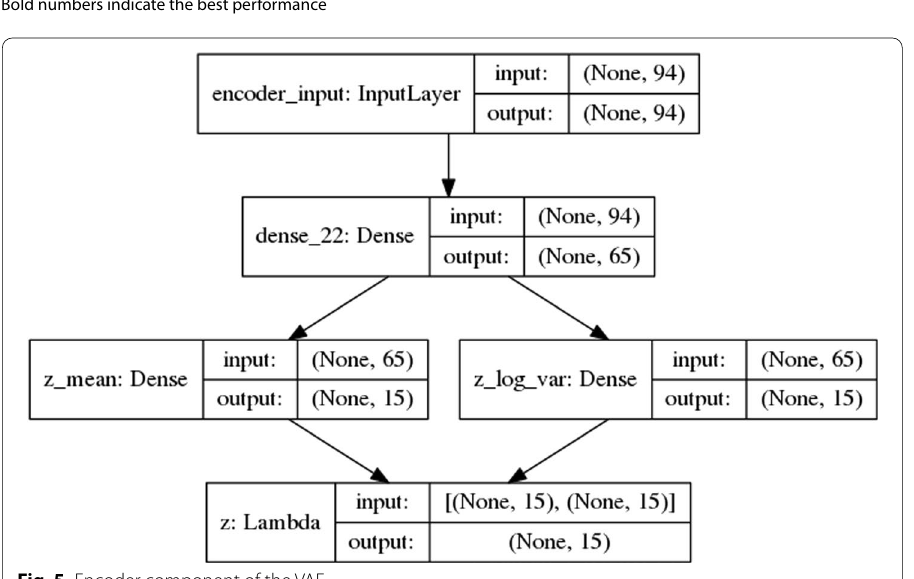
Fig. 5 Encoder component of the